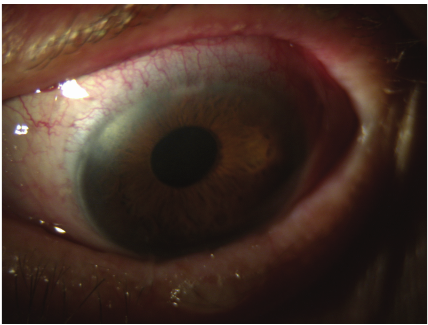
Figure 11: Left eye after 8 weeks of